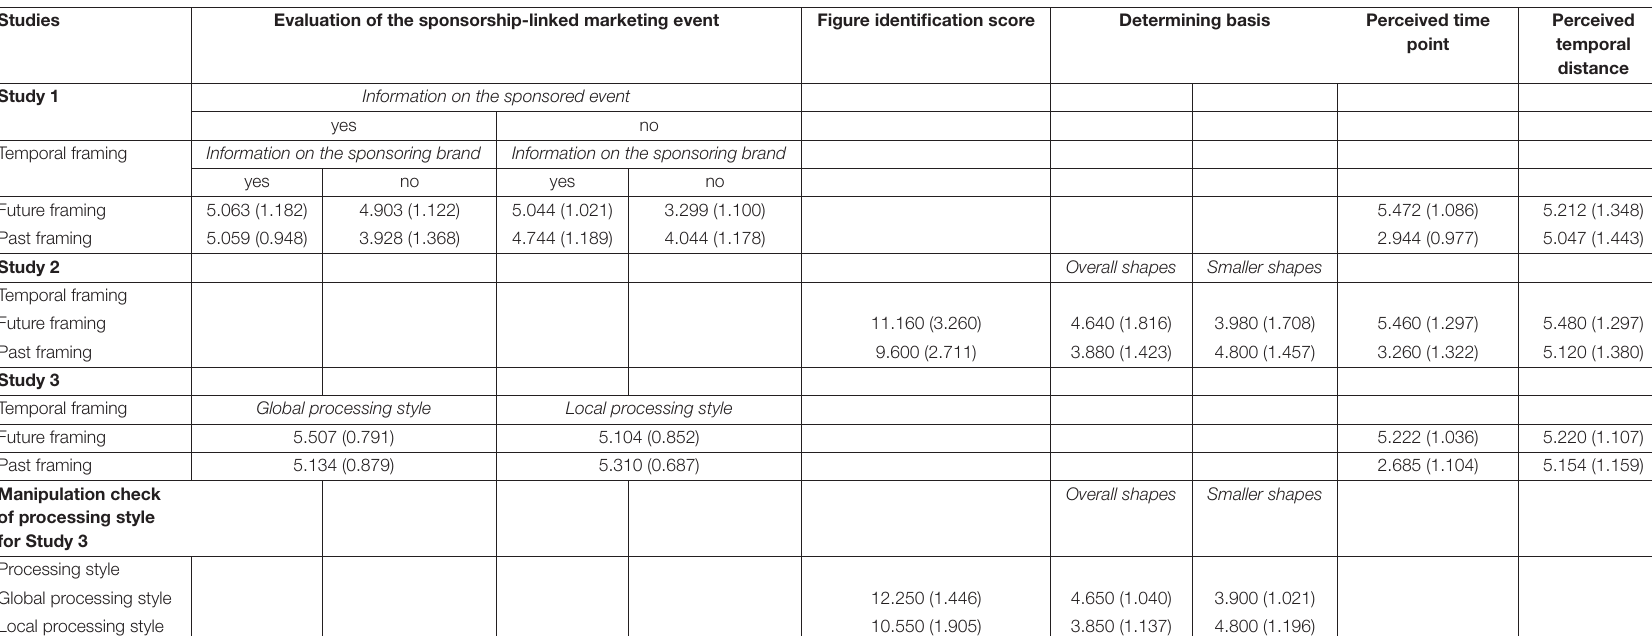
TABLE 2 | Means and standard deviations for variables and manipulation checks (Study 1–Study 3).